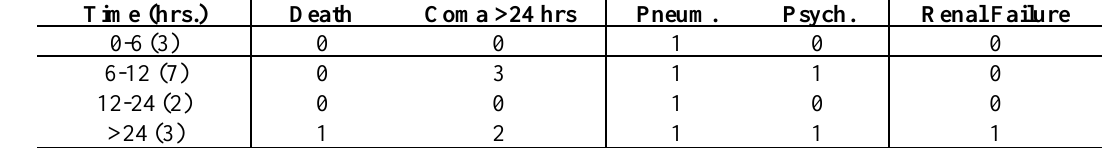
Table VI : Maternal outcome - fit to start of anticonvulsants (n = 15)** Time